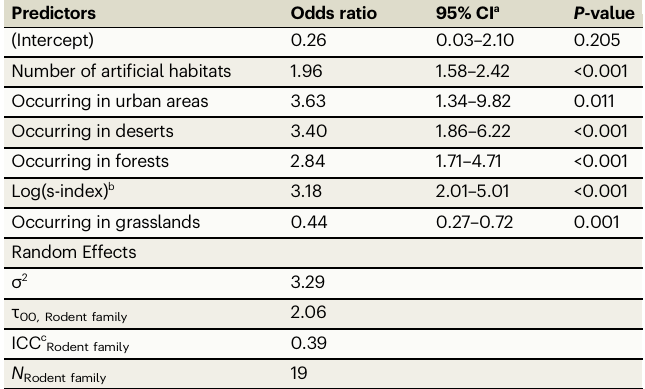
Table 3 | Summary of best- fi t generalized linear mixed effects model for synanthropic status ( n = 269)